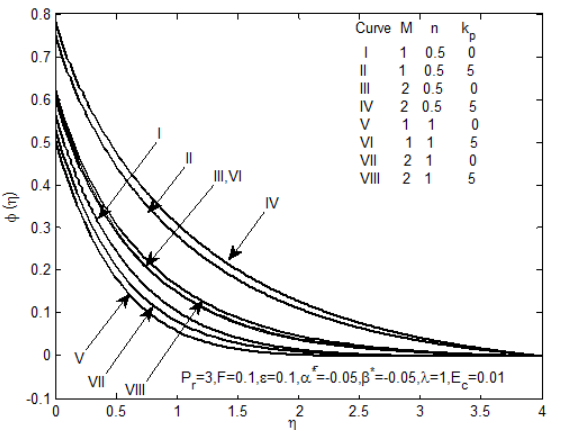
Figure 18: Temperature profiles (PHF case)